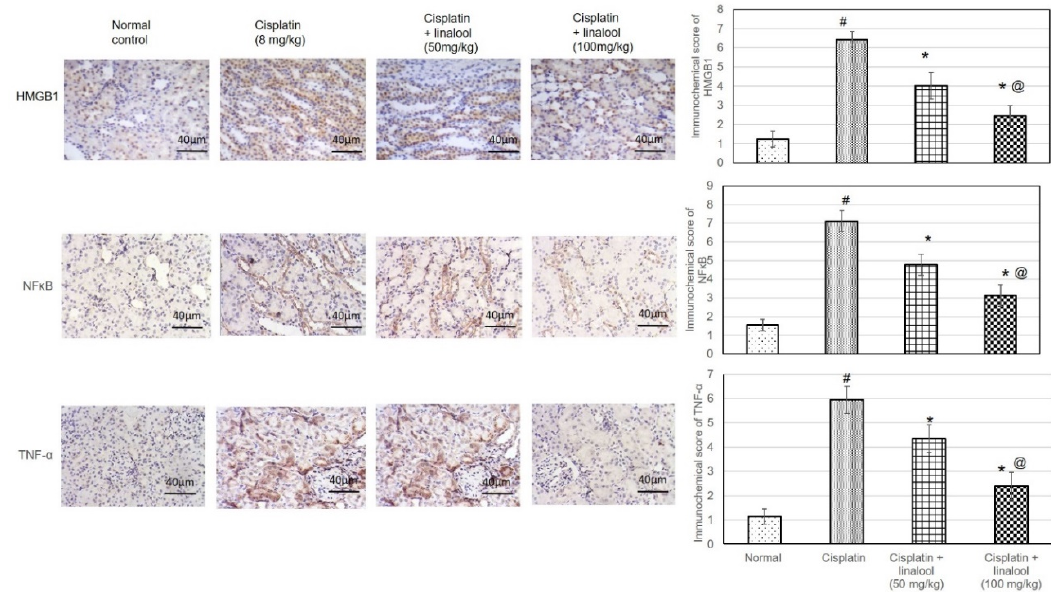
Figure 7. Immunohistochemical staining of renal tissues with HMBG1, NF-κB, and TNF-α antibodies after cisplatin induction of kidney injury. Pre-treatment with linalool (50 and 100 mg/kg) for 14 days diminished the number of positive cells containing HMBG1, NF-κB, and TNF-α. All values are expressed as mean ± SD ( n = 3). # denotes statistically significant from the normal control group, * indicates statistically significant from the cisplatin-only group, and @ represents statistically significant from the cisplatin + linalool 50 mg / kg group ( p < 0.05) using one-way ANOVA followed by Tukey’s post-hoc